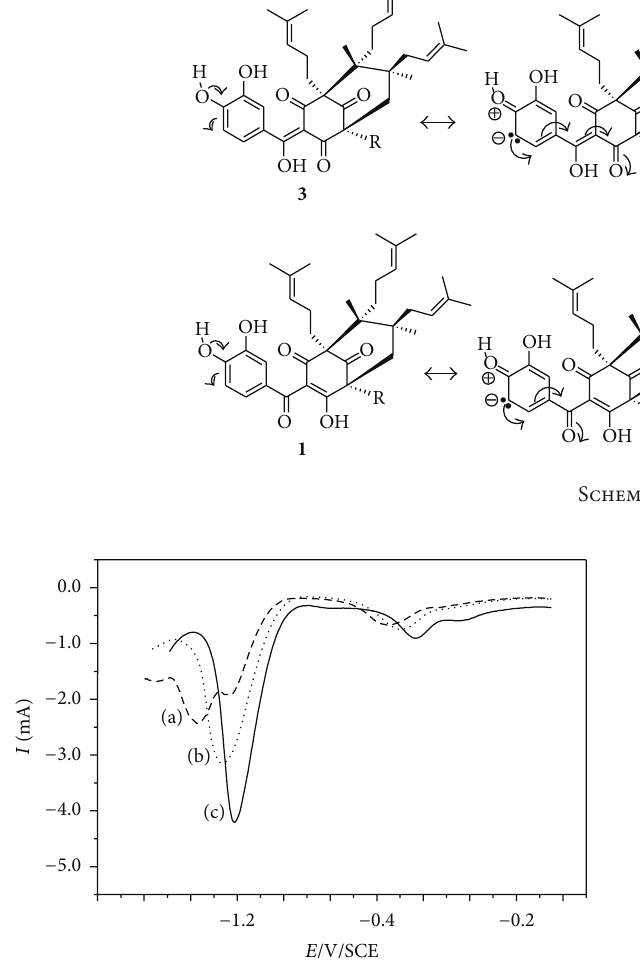
Figure 9: Consecutive net SWV voltammograms recorded with a thinfilm electrode in contact with aqueous medium at pH = 1. The parameters of the potential modulation are the same as for Figure